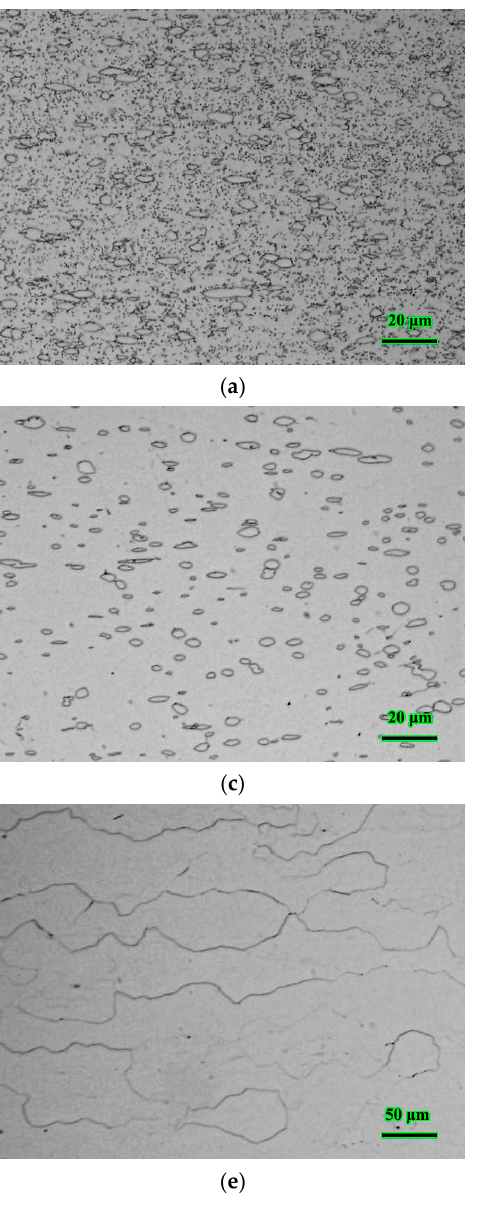
Figure 11. The microstructure of different deformation temperatures at 0.001 s − 1 : ( a ) 715 °C; ( b ) 735 °C; ( c ) 755 °C; ( d ) 775 °C; ( e ) 810 °C; ( f ) 840 °C .